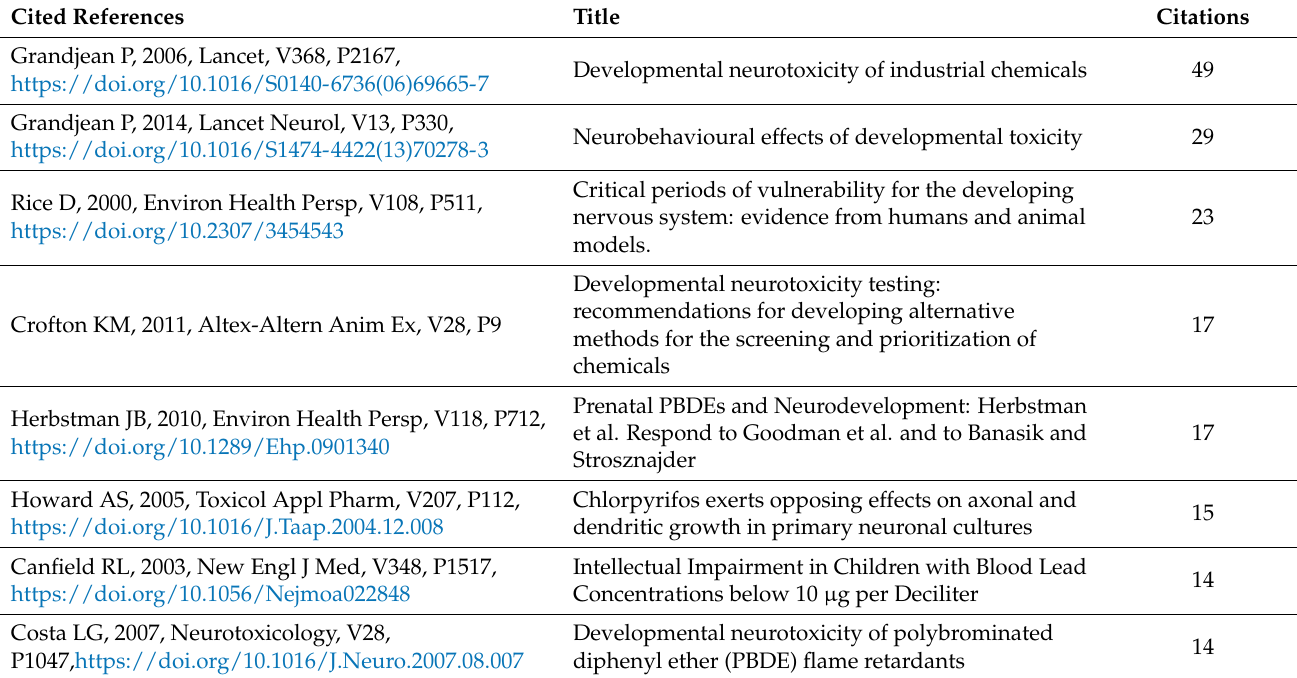
Table 6. Most locally cited references from 2011 to